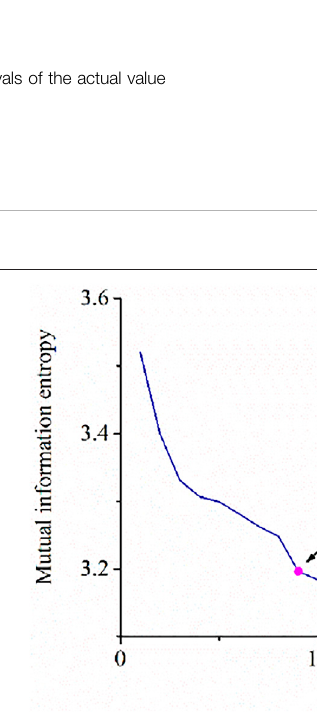
FIGURE 3 | Computation of the mutual information